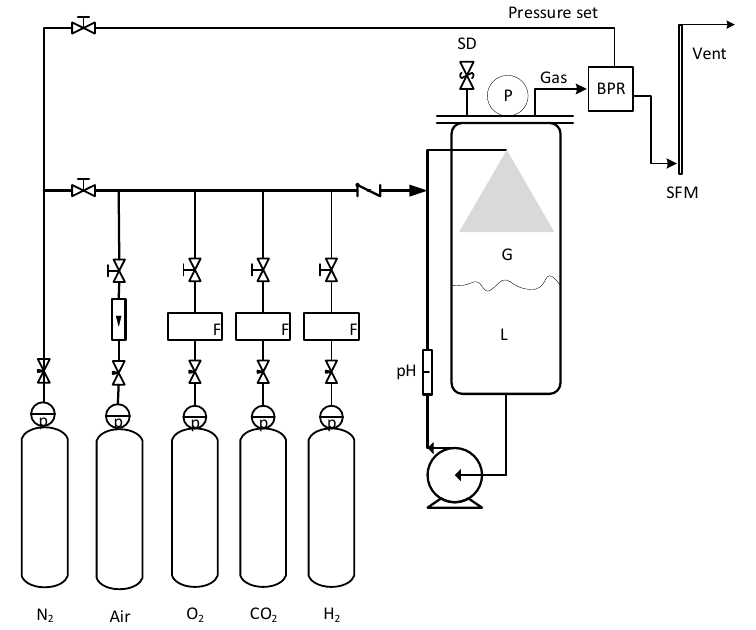
Figure 1. A pressured bioreactor setup consisting of a stainless steel vessel (4L), gas cylinders, gas mass flow meters (F), in-line pH probe (pH), safety disk (SD), pressure gauge (P), and soap film meter (SFM).